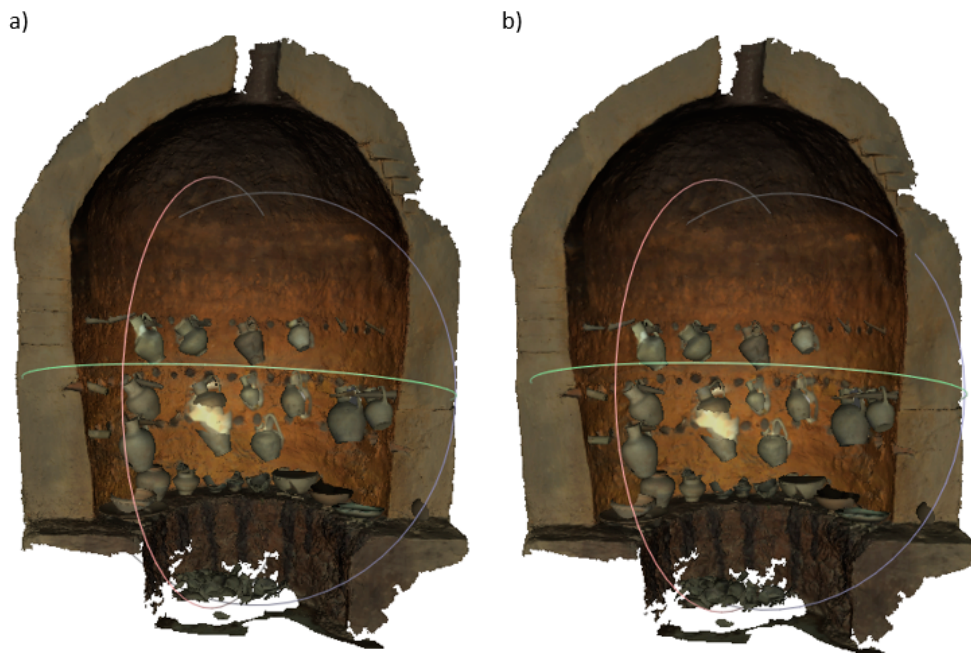
Figure 13. Three-dimensional model of the furnace ( a ) original model, ( b ) after optimalisation.